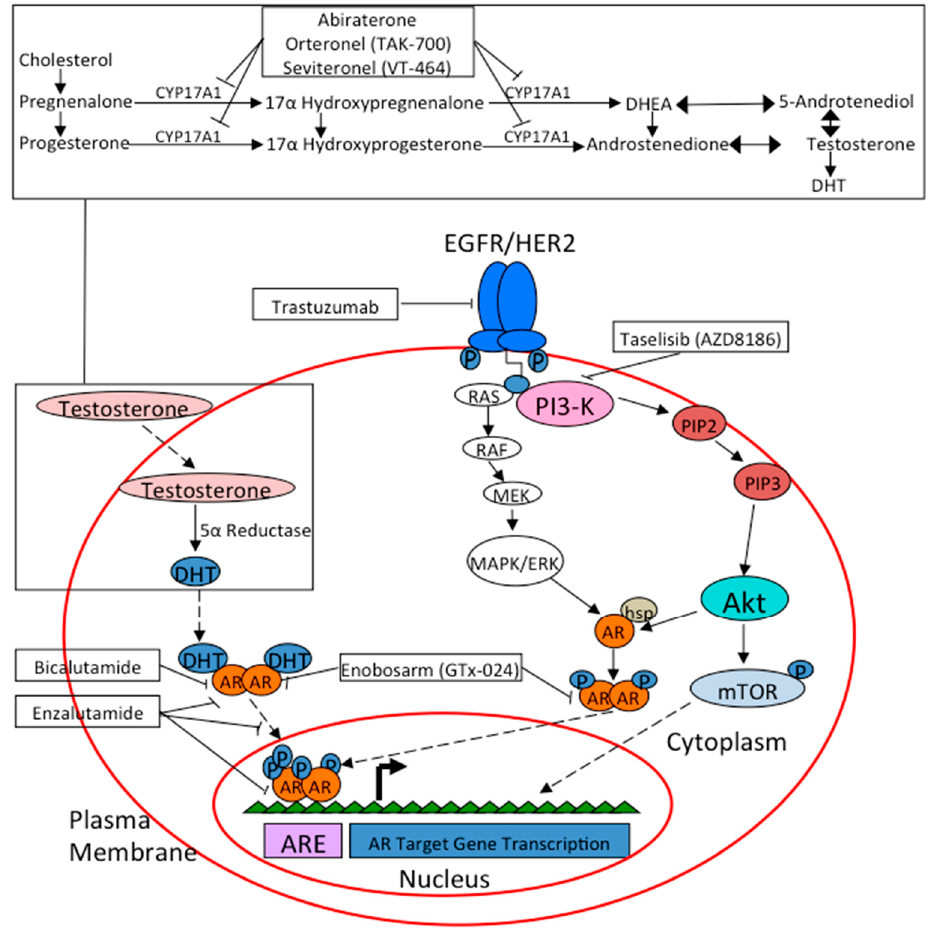
Figure 2. Drug targets in AR signaling pathway.